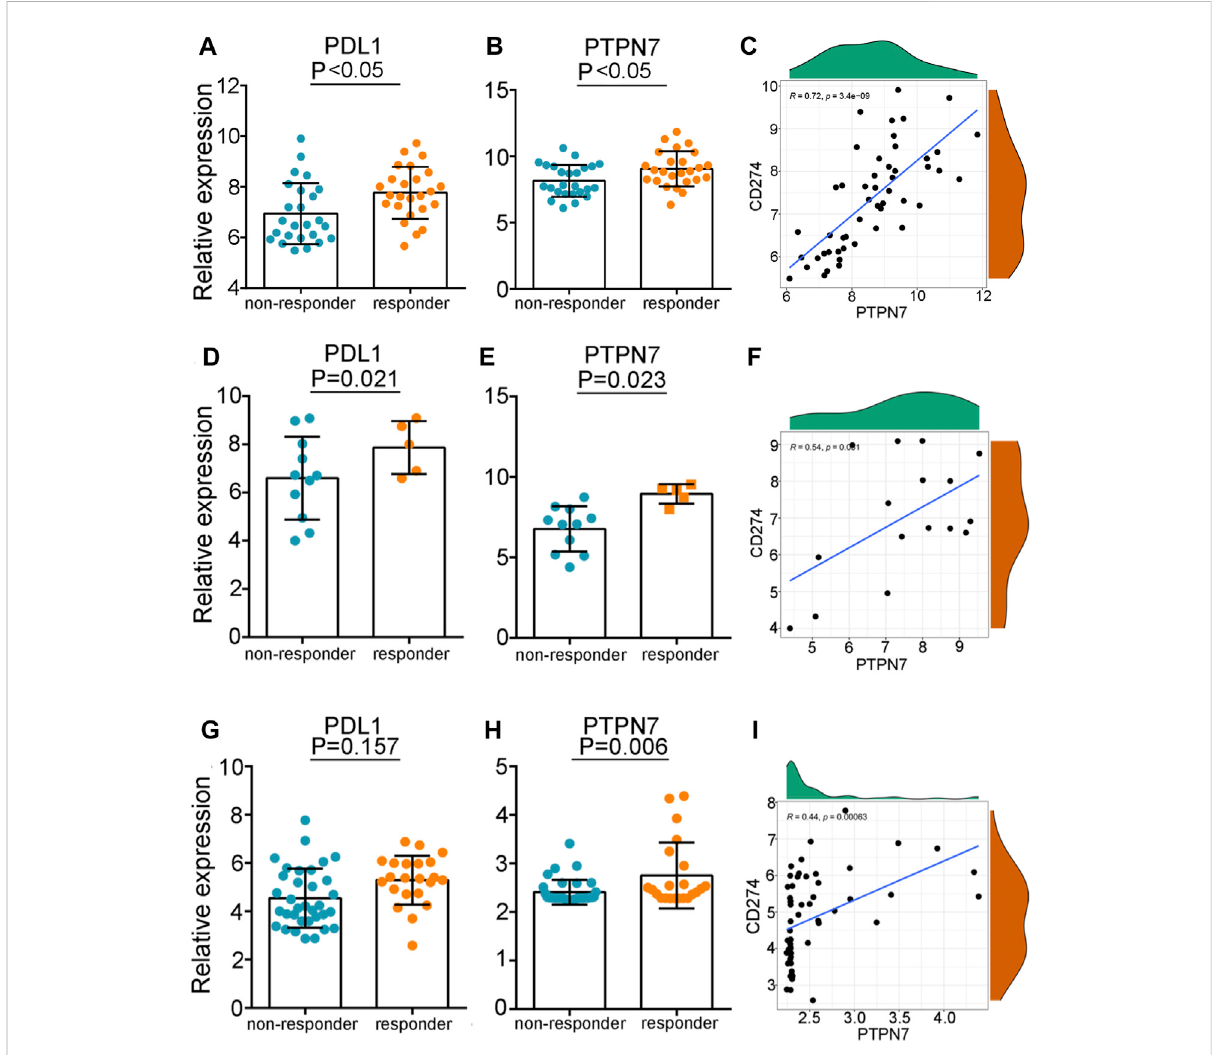
FIGURE 7 The predictive values of PTPN7 for immunotherapy. (A,D,G) Expression of PD-L1 in patients with different responses to immunotherapy in the three GEO cohorts. (B,E,H) Expression of PTPN7 inpatients with differentresponses to immunotherapy inthe three GEO cohorts. (C,F,I) Correlation between PD-L1 and PTPN7 in the three GEO